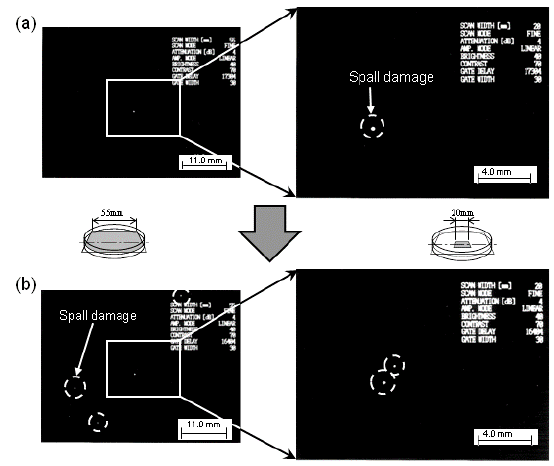
Figure 5. The spall damage in medium carbon steel generated after the fourth (a) and fifth (b) impact during low-velocity re- peated impact tests. The exposed particular data (C-scan image at the 3.5 mm depth) were registered for the sample No. R2. The spall damage nucleated by the fourth impact was increased by the fifth impact.